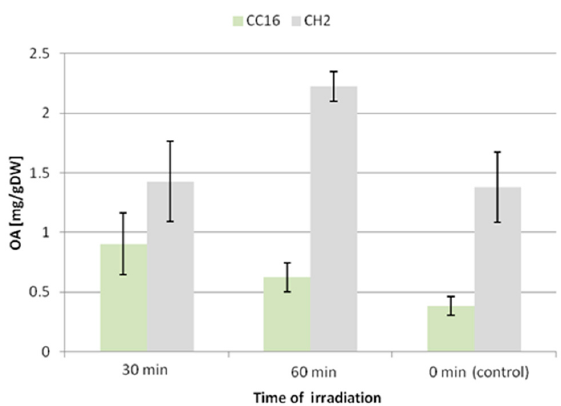
Figure 8. The content of oleanolic acid in hairy root tissue after elicitation with UV radiation. OA—oleanolic acid.